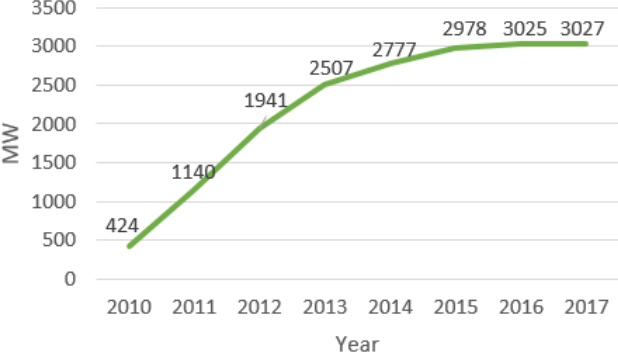
Figure 2. Pi [MW] of wind power plant (WPP) in Romania during 2010–2017.